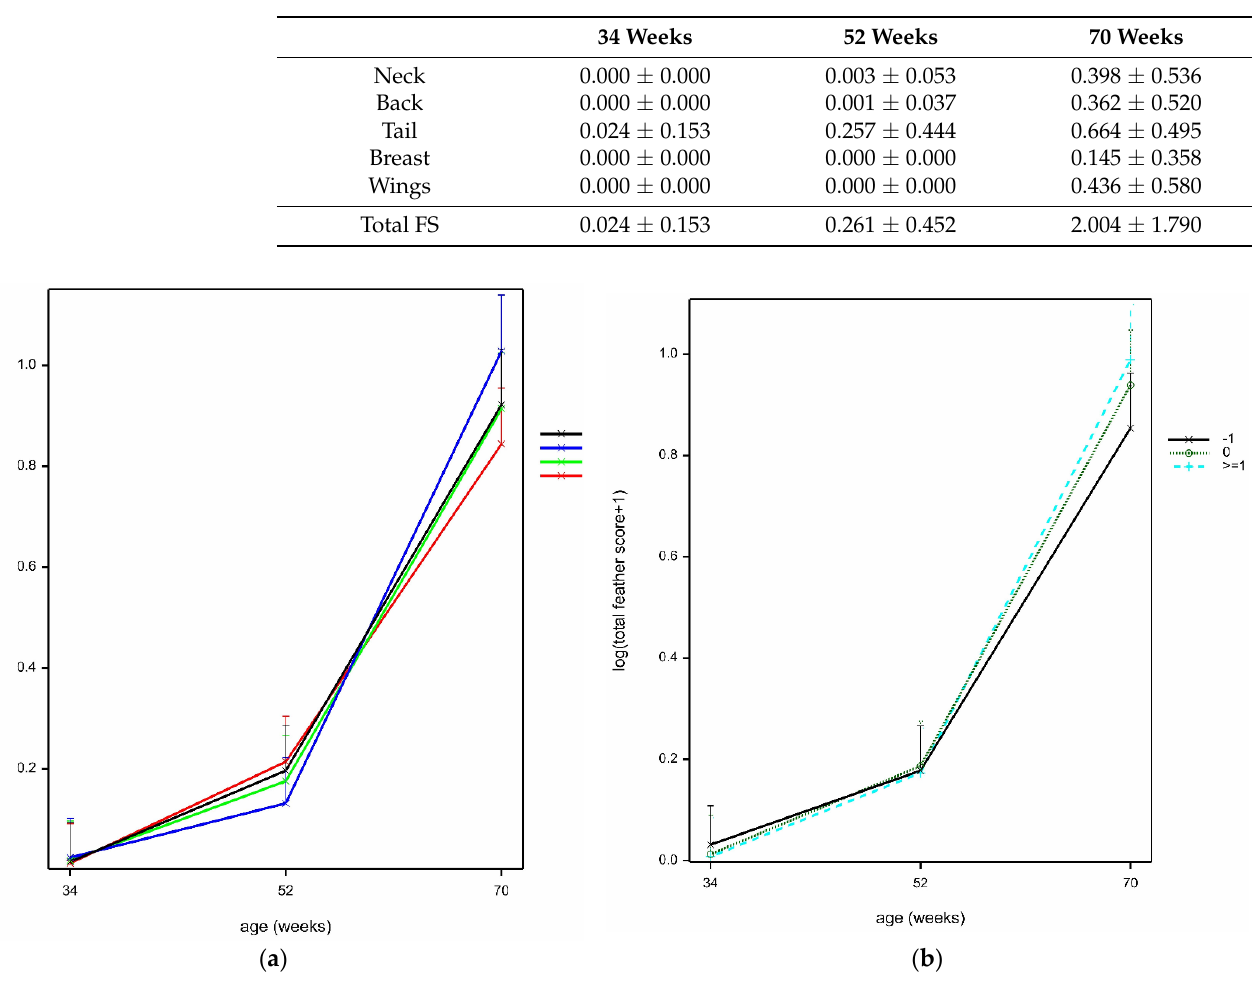
Table 6. Mean ± SD feather score by bird age and body location (overall treatments and flocks) and mean ± SD total feather score (FS).